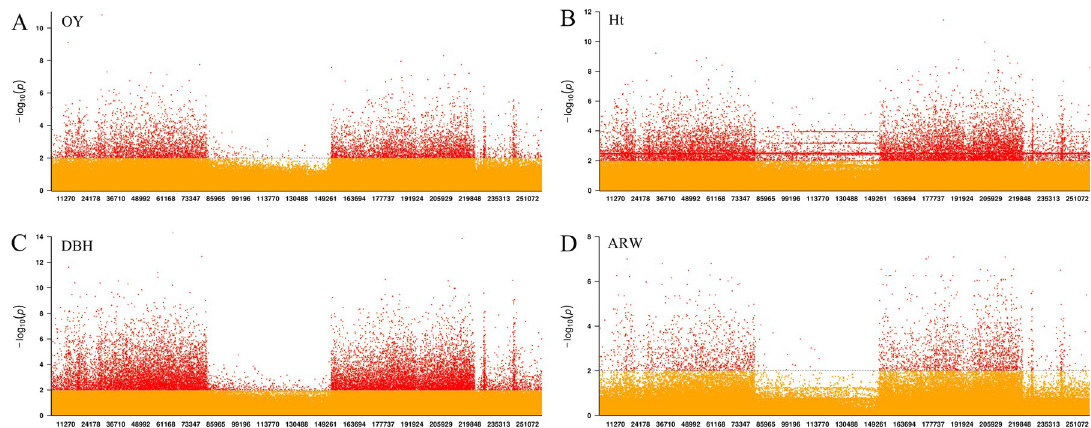
Fig 5. GEM-based association analysis, as a Manhattan plot. A Associations between SNPs and oleoresin yield. B The results of the association between SNPs and tree height. C Associations between SNPs and diameter at breast height. D Associations between SNPs and ARW. Significant and extremely significant threshold lines are represented by orange and red dashed lines, respectively. Significant and extremely significant SNP sites are represented by enlarged green and red solid points, respectively.